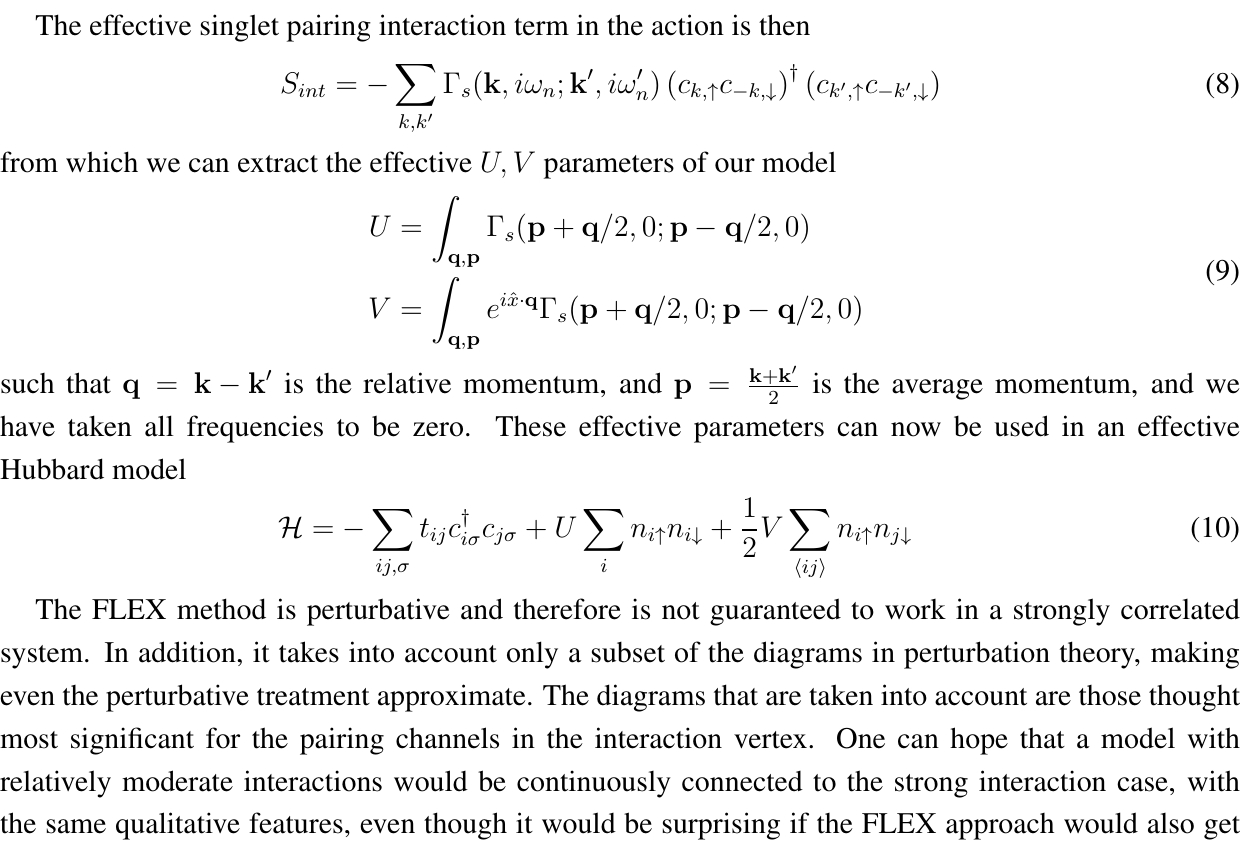
Figure 1. The effective attractive off-site interaction V as a function of the bare repulsive, off-site, interaction V in units of the on-site repulsion U . In the calculation the values t = 488 meV and U = 2 . 56 eV were used. The (bare) repulsive V meV . The values taken for the bare repulsive V bulk LCO as found in Reference